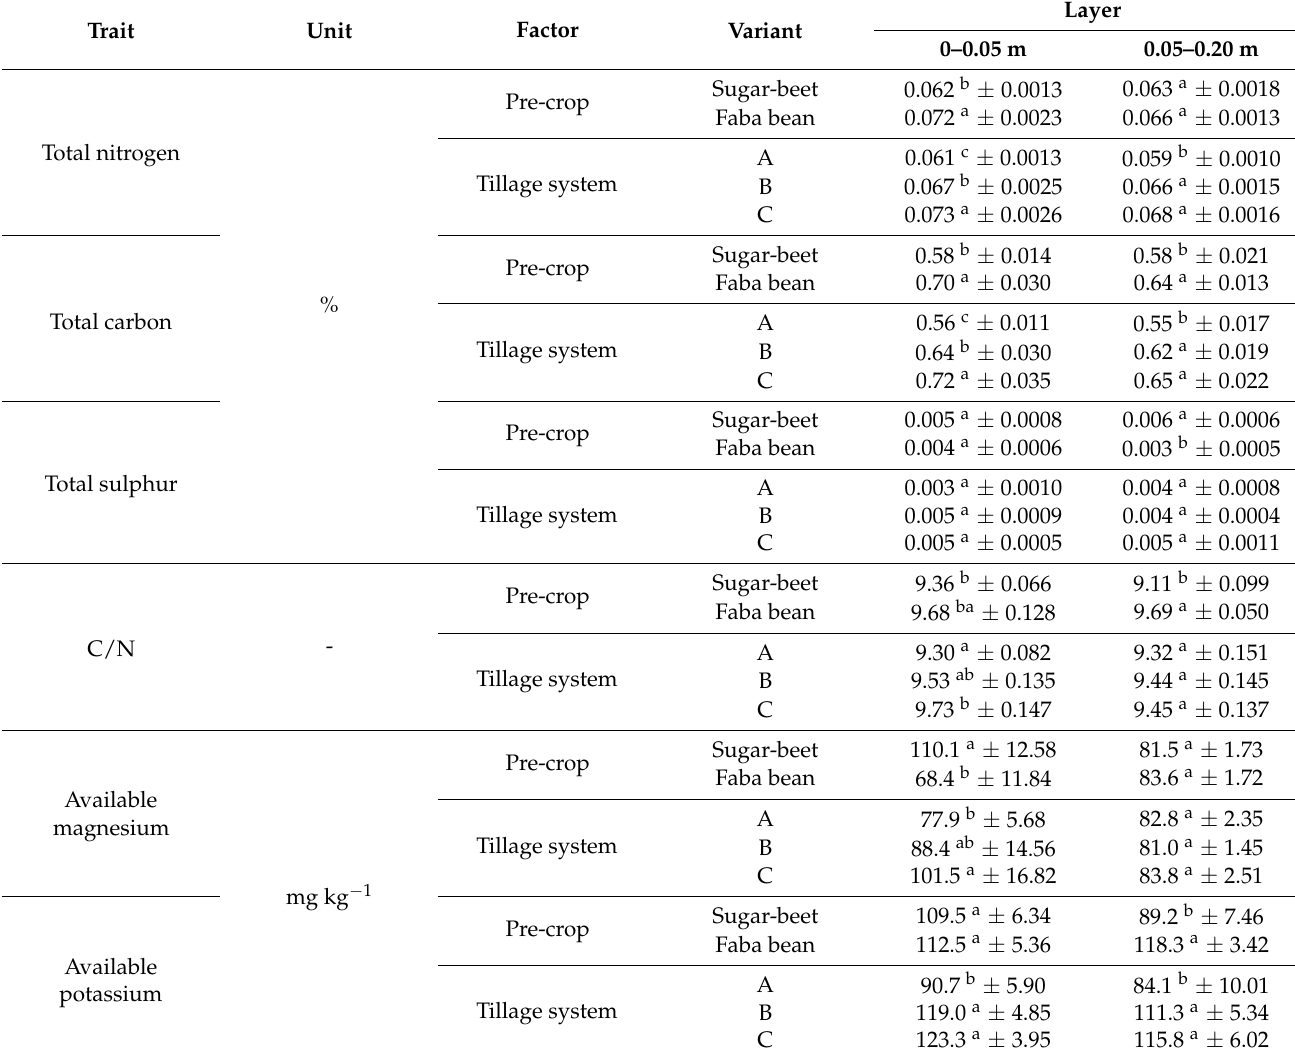
Table 3. Macro-nutrients contents in soil depending on pre-crop and tillage